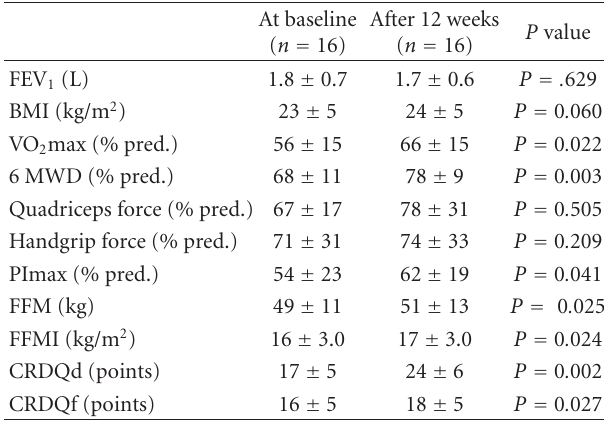
Table 2: The e ff ects of a 12-week multidisciplinary pulmonary rehabilitation